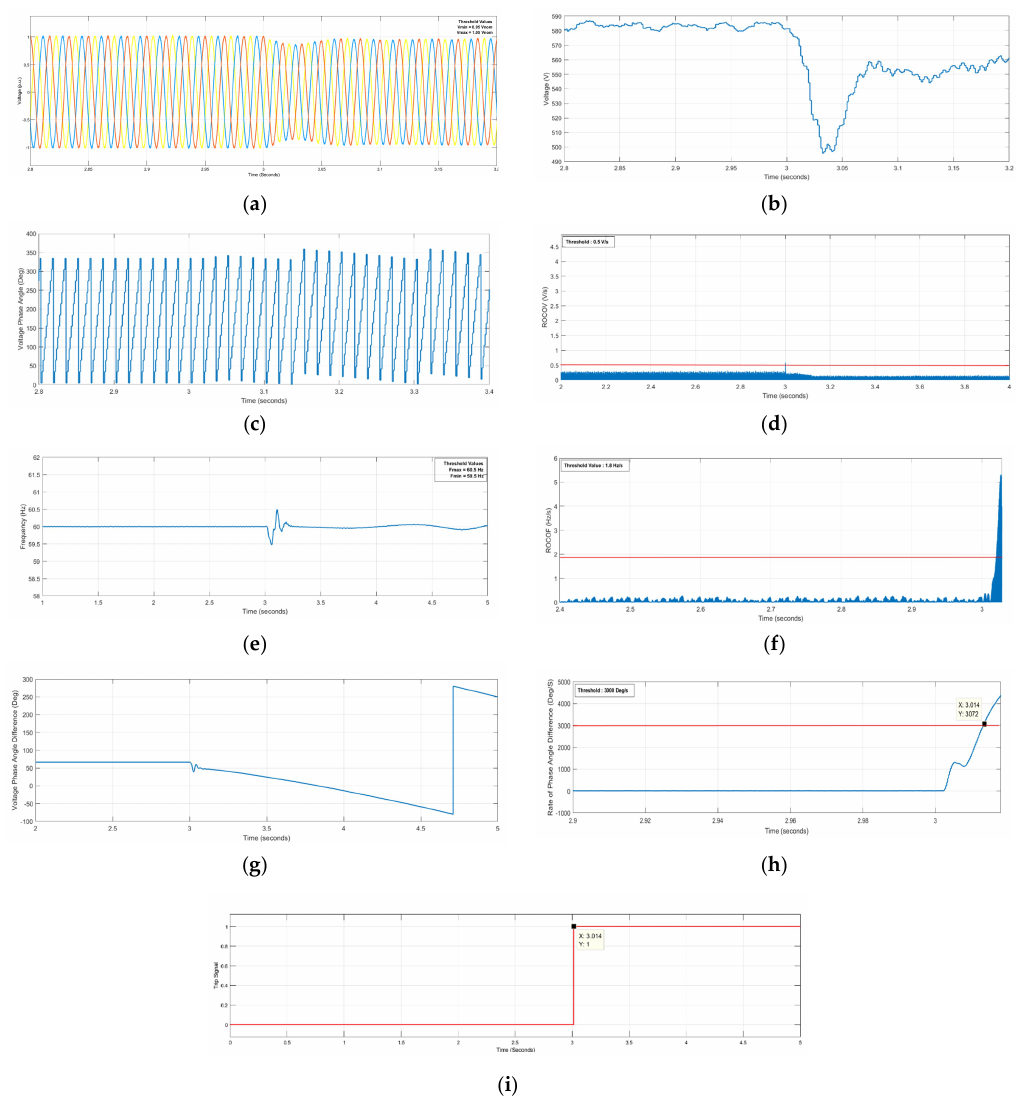
Figure 11. Results of case (iii) Islanding condition: power generated by DG ≈ power requirement of local loads. ( a ) Feeder voltage; ( b ) DG voltage magnitude; ( c ) DG voltage phase angle; ( d ) ROCOV relay; ( e ) frequency relay; ( f ) ROCOF relay; ( g ) Voltage phase angle difference; ( h ) Rate of change of voltage phase angle difference; ( i )Trip Signal.